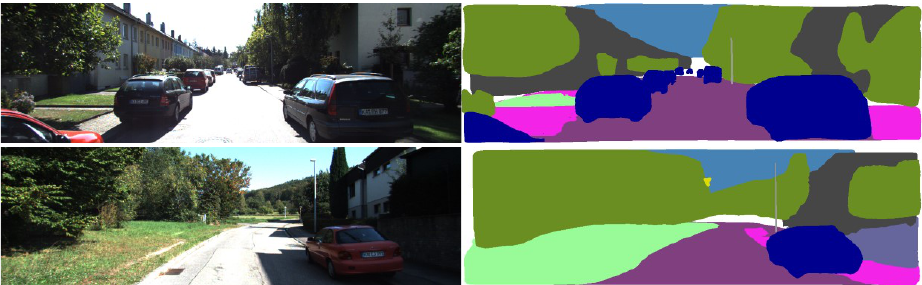
Figure 3. Semantic segmentation results in KITTI Visual Odometery